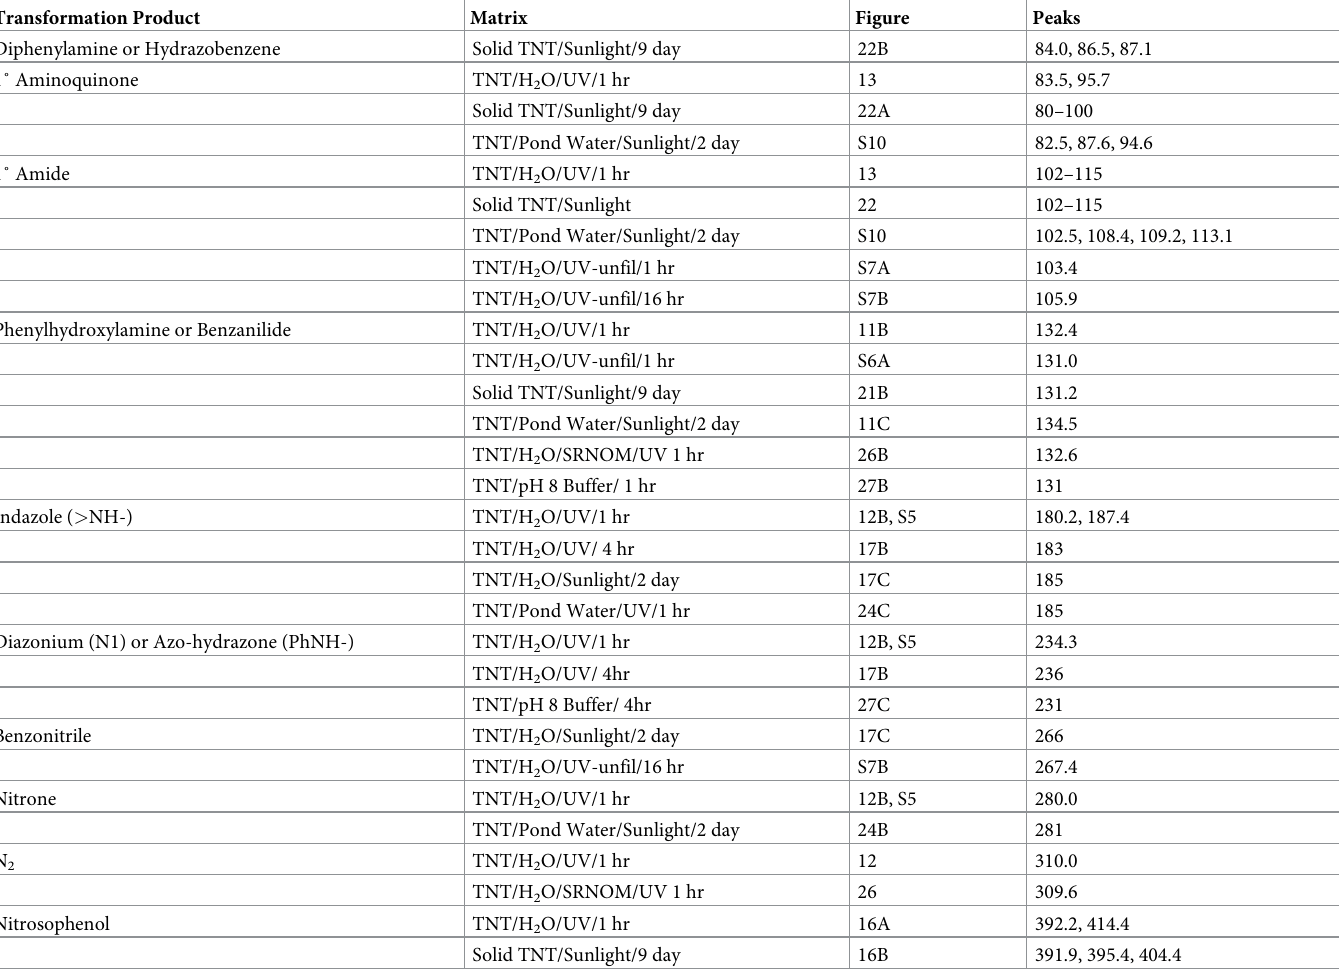
Table 6. Previously unreported or underestimated TNT phototransformation products detected by N-15 NMR. Transformation Product Matrix Figure Peaks Diphenylamine or Hydrazobenzene Solid TNT/Sunlight/9 day 22B 84.0, 86.5,